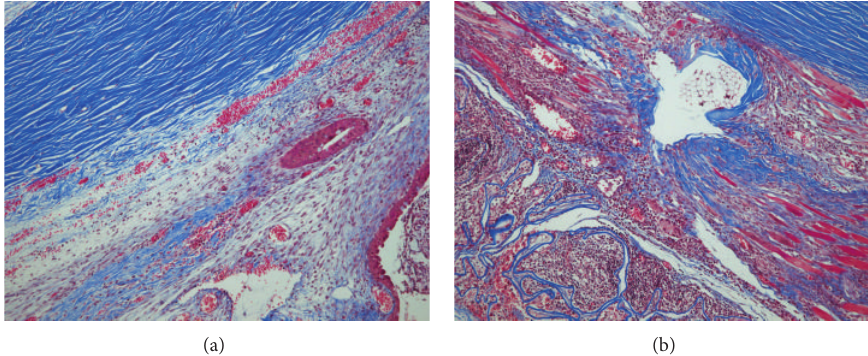
Figure 4: Fibrosis in a control eye (a) and an AM eye (b) with Masson’s trichrome stain and 100x